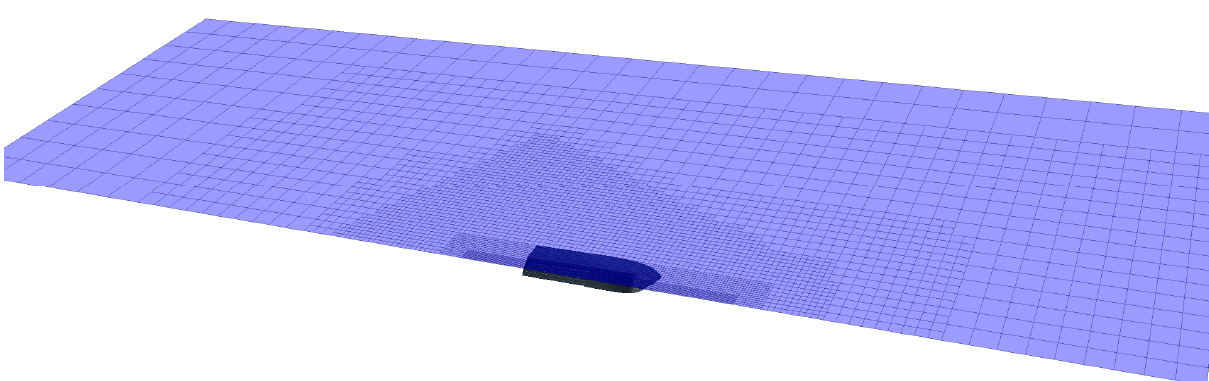
Figure 6. Mesh in all regions of the simulation. It is possible to notice the overset refinement.